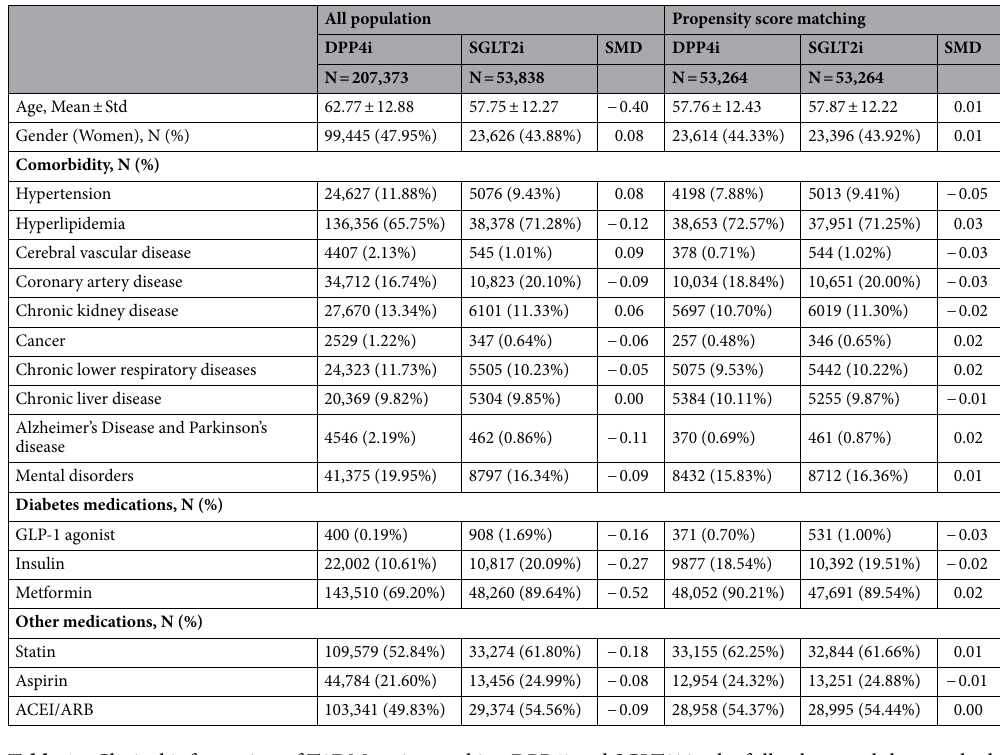
Table 1. Clinical information of T2DM patients taking DPP4i and SGLT2i in the full cohort and the matched cohort.